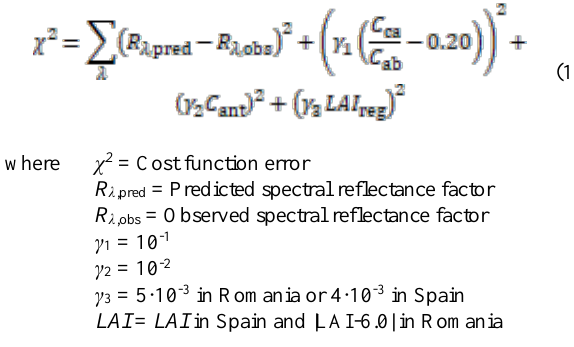
transfer inversion could be evaluated using field